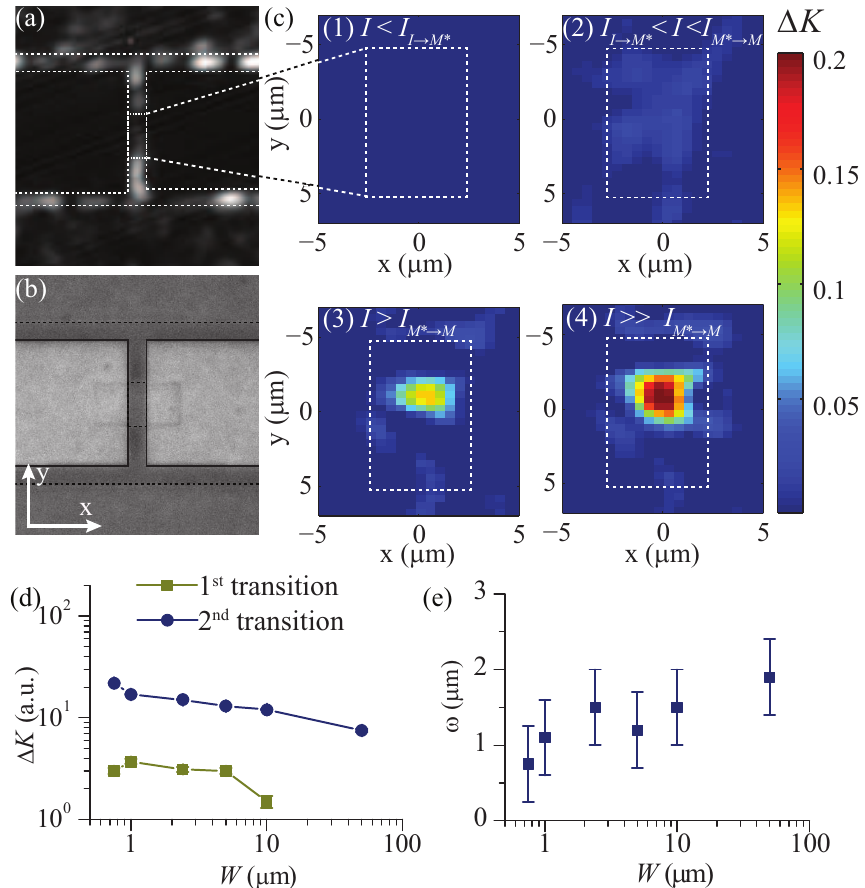
Figure 5. The ( a ) infrared and ( b ) visible optical images of the VO µ m and L = 5 µ m. ( c ) The decrease in the infrared optical transmission as the current is increased. Each sub-figure corresponds to a current labelled in Figure 3a. ( d ) The decrease in the infrared optical transmission after each transition and ( e ) the width of the filament as a function of W when L = 5 µ